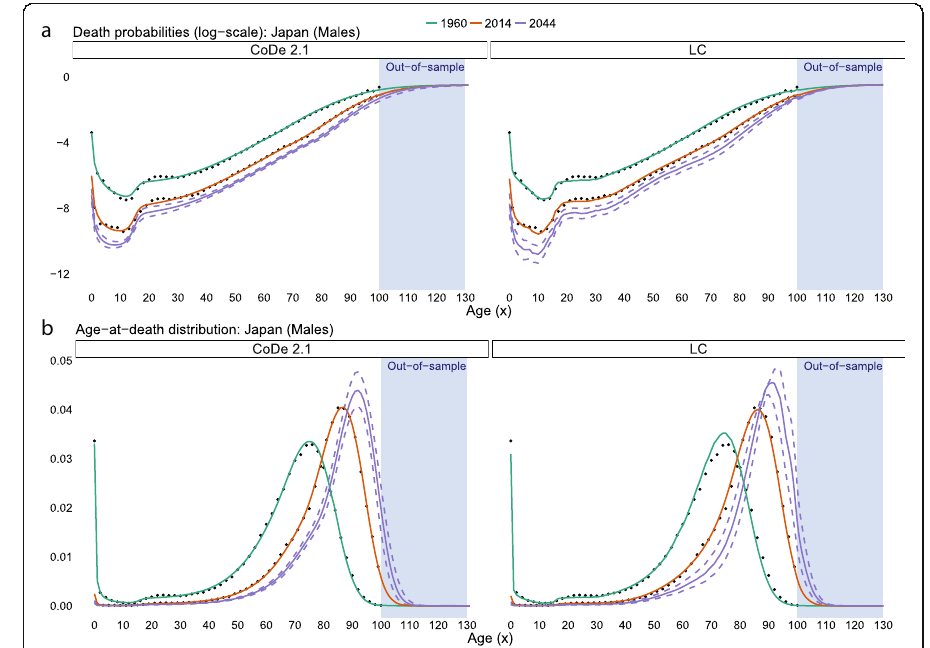
Fig. 8 Estimations and projections of the death probabilities and the age-at-death distribution for Japanese males for the years 1960, 2014, and 2044 and for ages 0 – 130. CoDe 2.1 (left) and LC (right). The dotted lines are observations and the dashed lines are 95% projection intervals. The reference period is 1960 – 2014 for